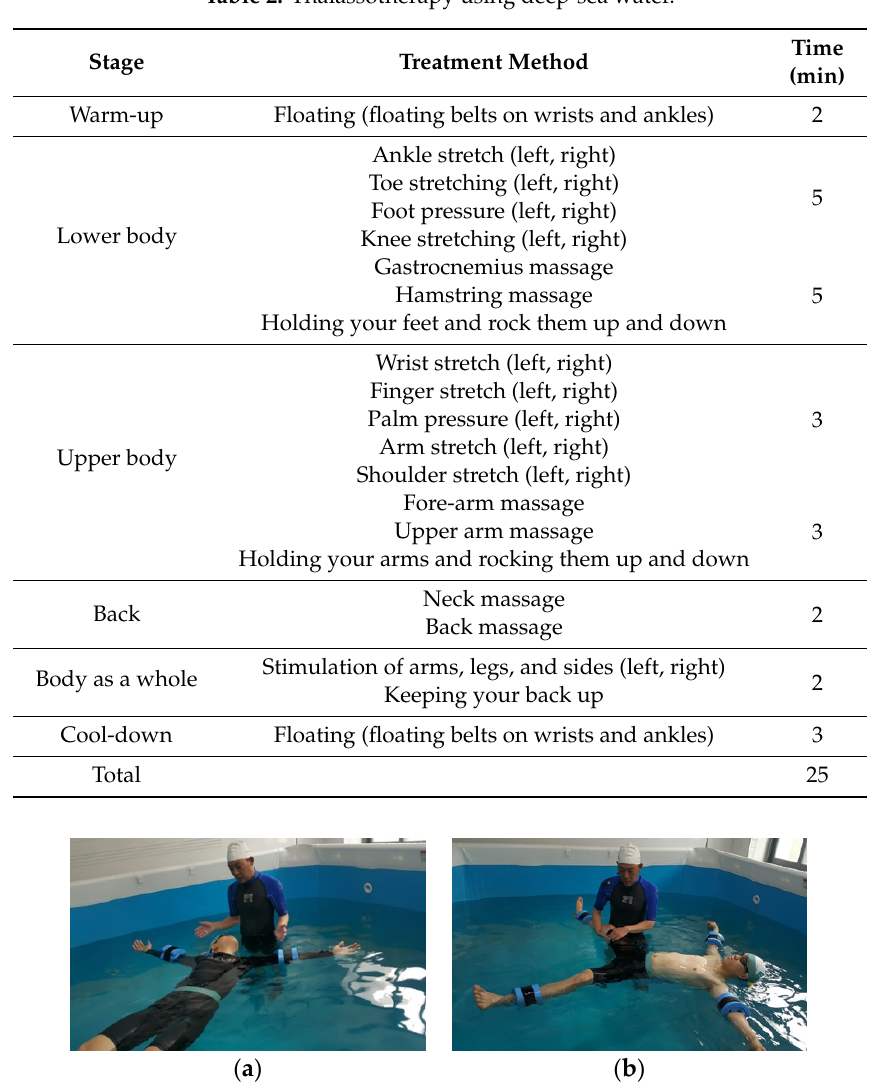
Table 2. Thalassotherapy using deep-sea water.